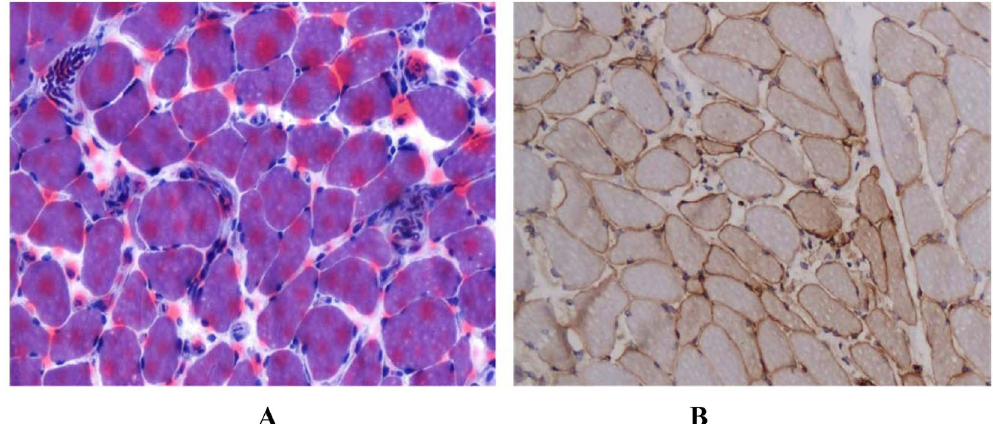
Figure 1. Histologic and immunohistologic analysis of muscle biopsies from the biceps of an anti-SAE antibody-positive patient. ( A ) Stain with HE ( B ) stain with anti-MHC-I